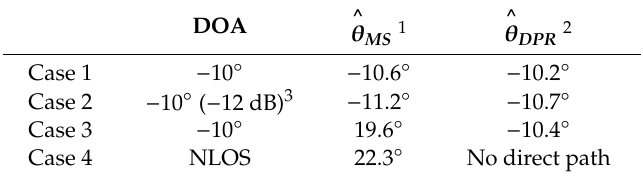
Table 2. The outcome of the proposed DPR method and the multipath suppression method.